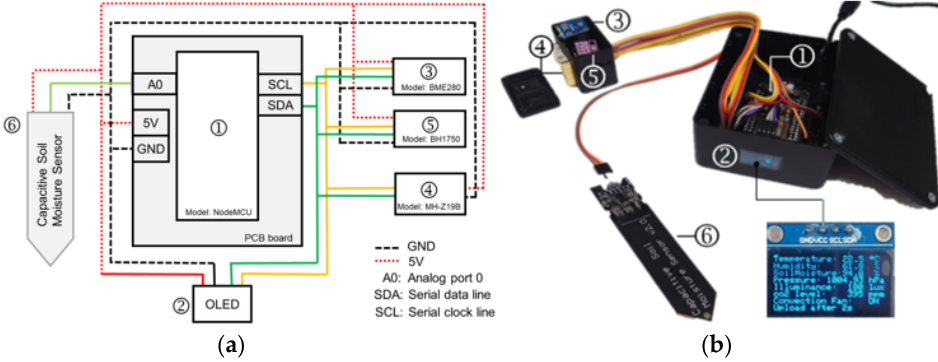
Figure 6. Environmental sensing and display module: ( a ) circuit layout, ( b ) appearance of the module. : microcontroller chip; : OLED display interface; : environmental sensing chip set; : carbon dioxide sensor; : light sensor; : soil moisture sensor.